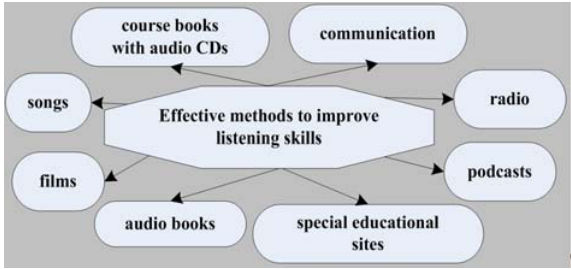
Figure 1. The most effective methods to improve listening